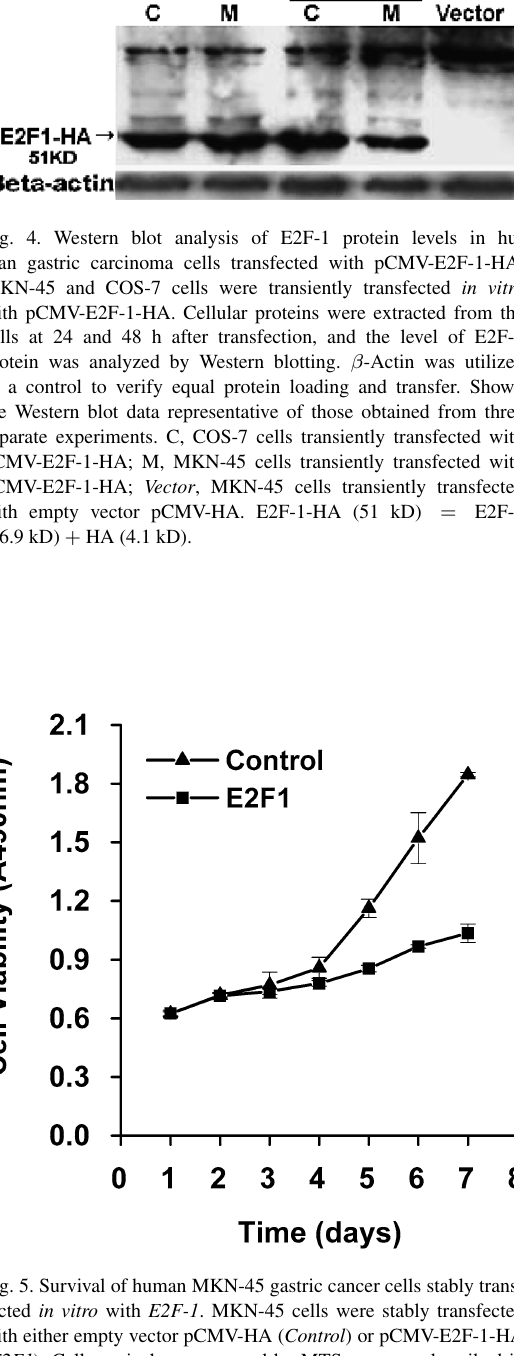
Fig. 5. Survival of human MKN-45 gastric cancer cells stably trans- fected in vitro with E2F-1 . MKN-45 cells were stably transfected with either empty vector pCMV-HA ( Control ) or pCMV-E2F-1-HA ( E2F1 ). Cell survival was assessed by MTS assay, as described in Patients and methods . The results represent the means of at least three independent experiments. The inhibition of proliferation was observed after 24 h of MTS treatment in MKN-45 cells stably trans- fected with pCMV-E2F-1-HA. P < 0 . 01 for the control group vs. E2F-1